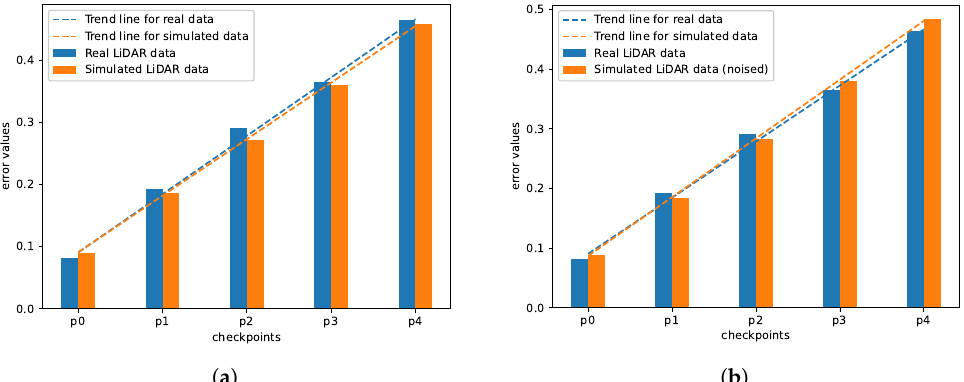
Figure 11. SLAM accuracy metric for real data and simulated data on the first track: ( a ) without noise and with the rolling shutter effect ( b ) with added noise and the rolling shutter effect, distance between the checkpoints—1 m.